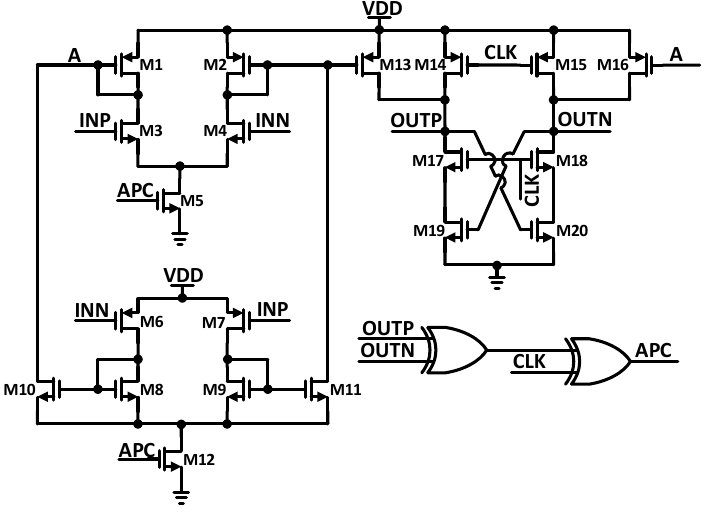
Figure 3. Schematic of rail-to-rail dynamic latch comparator and adaptive power control (APC).